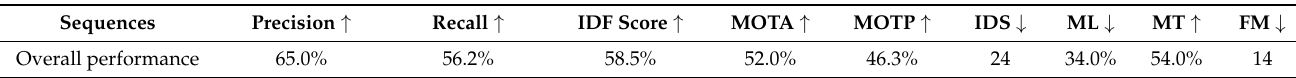
Table 5. Performance evaluation analysis of the proposed algorithm without Kalman filter on EPFL-RCL overlapping multi-cameras.